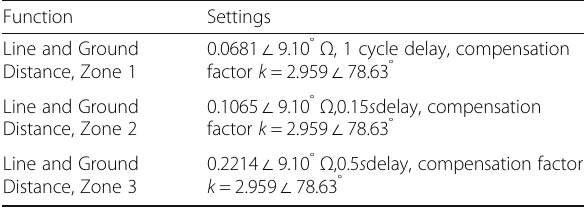
Table 3 Distance relay settings Function